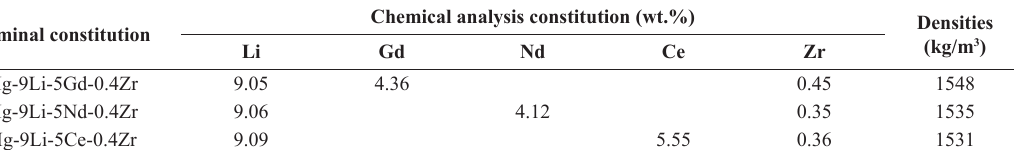
Chemical analysis constitution (wt.%)